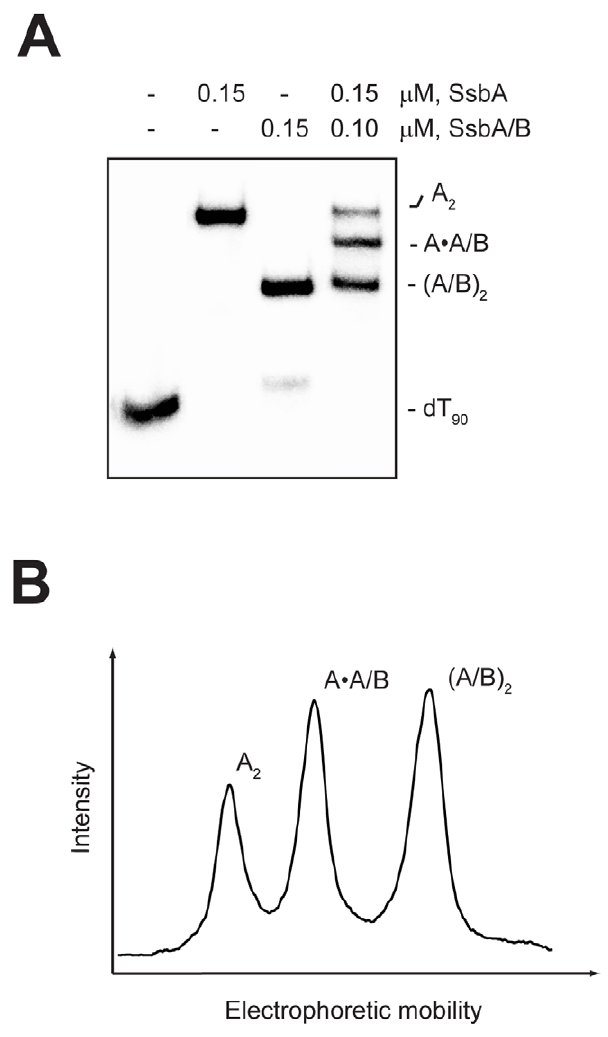
Figure 9. Binding of SsbA and SsbB RYTP proteins to dT 90 . The reaction solutions contained 25 mM Tris acetate (pH 7.5), 5 m M dT 90 (total nucleotide concentration), and the indicated concentrations of SsbA and SsbB RYTP protein (tetramer concentrations). A, The reactions were analyzed by polyacrylamide gel electrophoresis using a gel running buffer consisting of Tris acetate (pH 7.5). The bands corresponding to the unbound dT 90 oligomer, and the A 2 , B RYTP 2 , and A N B RYTP complexes, were visualized by phosphorimaging. B, The lane for the reaction that contained 0.15 m M SsbA and 0.15 m M SsbB RYTP was scanned to show the relative intensities of the bands for the indicated complexes.